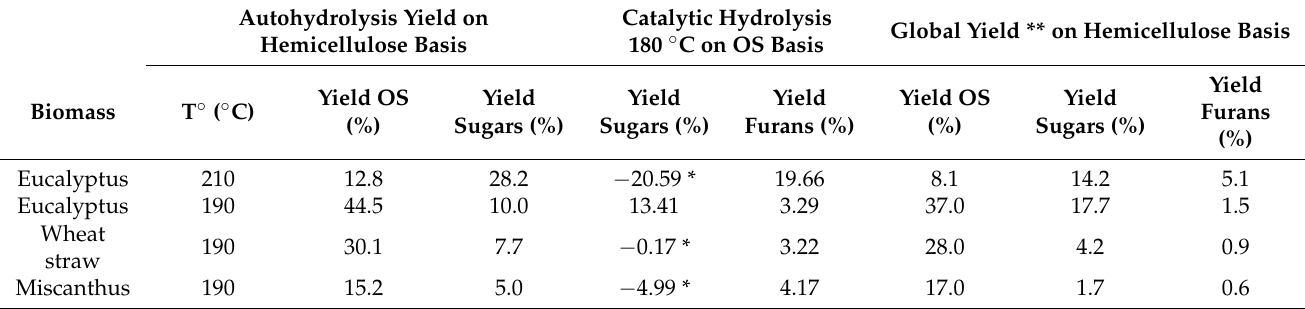
Table 5. Yields of autohydrolysis reactions, catalytic hydrolysis reactions and global